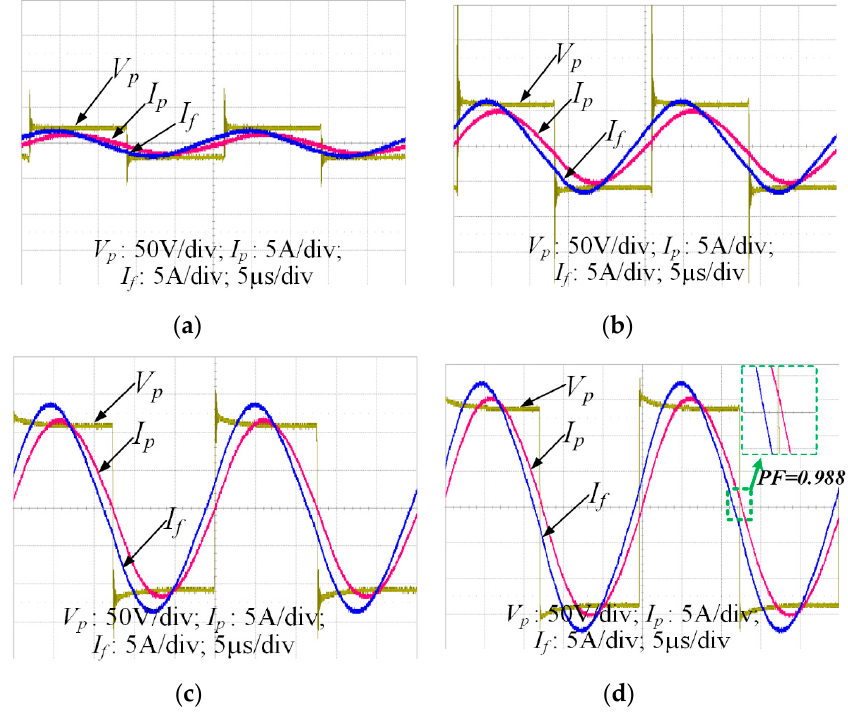
Figure 15. Waveforms of voltage and current at: ( a ) V p = 20 V; ( b ) V p = 60 V; ( c ) V p = 100 V; ( d ) V p = 140 V.